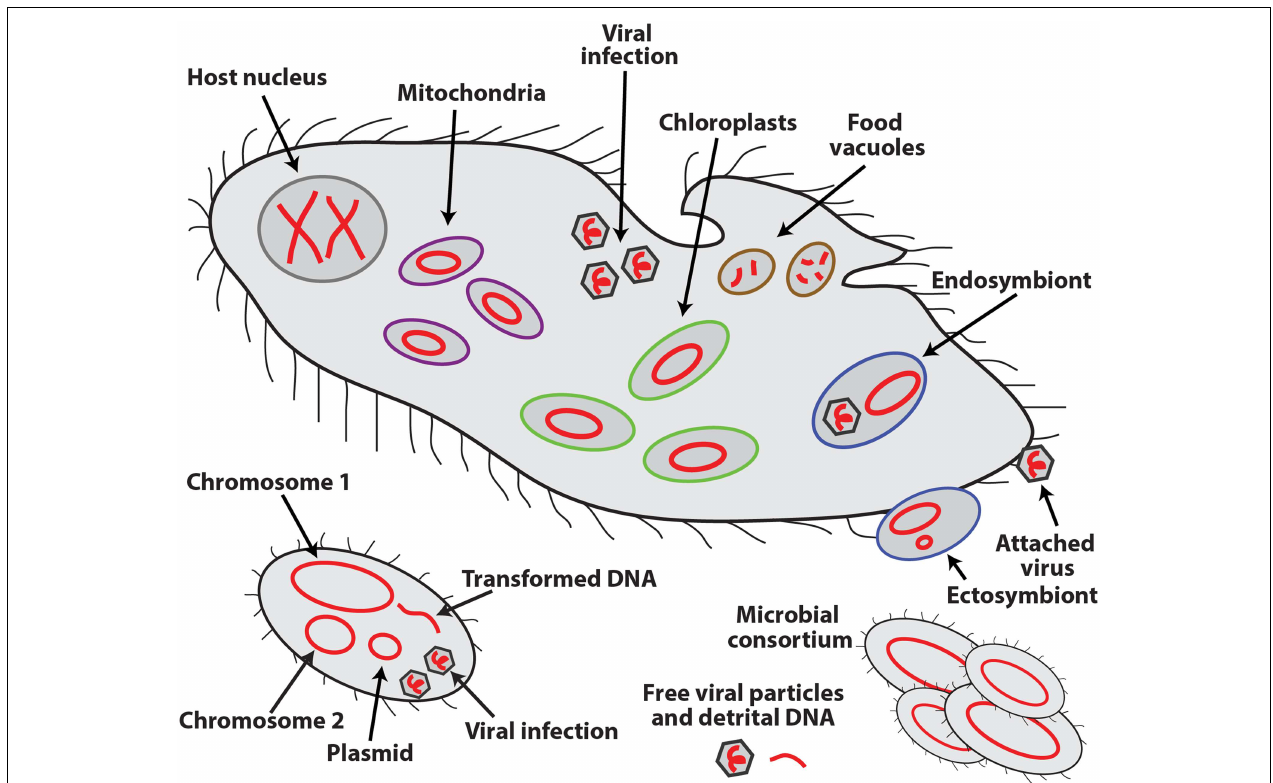
FIGURE 1 | Schematic representation of the various types of DNA molecules (in red) and their occurrence inside and outside of eukaryotic (top) and bacterial (bottom)